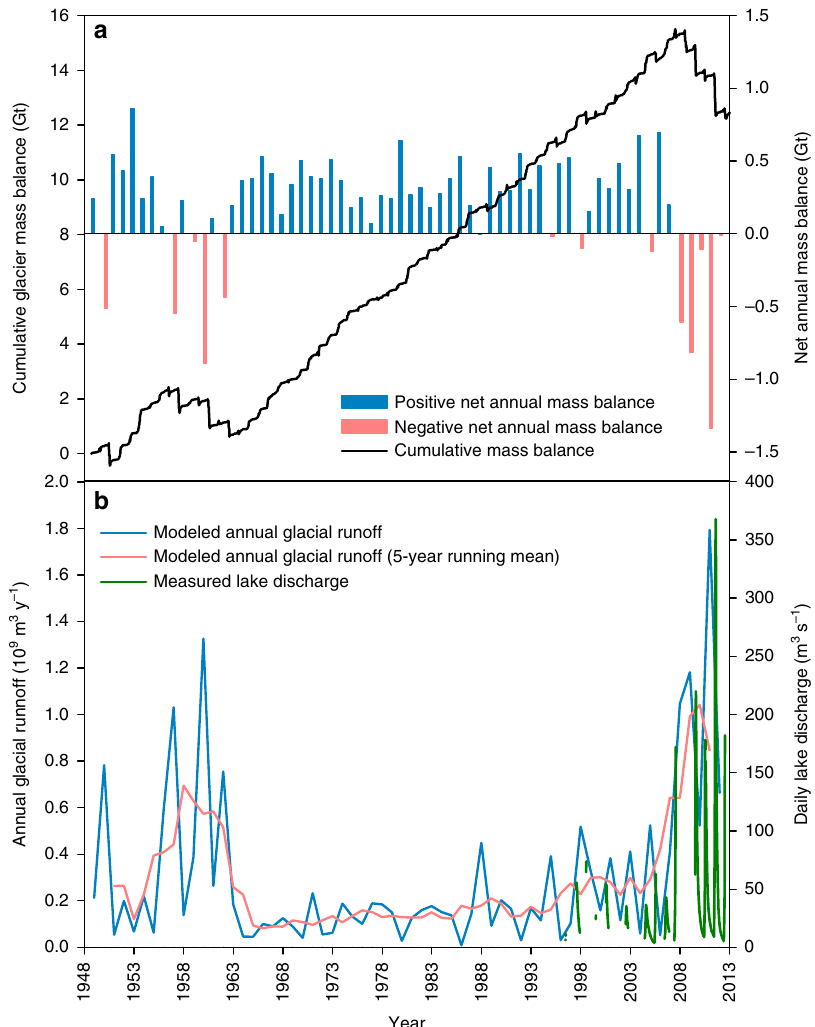
Fig. 4 Changes in glacier mass balance, glacial runoff and Lake Hazen discharge. a Modeled net annual mass balance (bars) and cumulative mass balance (line) for glaciers in the Lake Hazen watershed for 1948 – 2012. All values are in Gt, but note that the annual and cumulative mass balances are plotted on different y -axis scales. b Modeled glacial runoff (annual and 5-year running mean, 1948 – 2012) compared with measured daily discharge from Lake Hazen at the out fl ow (Ruggles River) from 1996 to